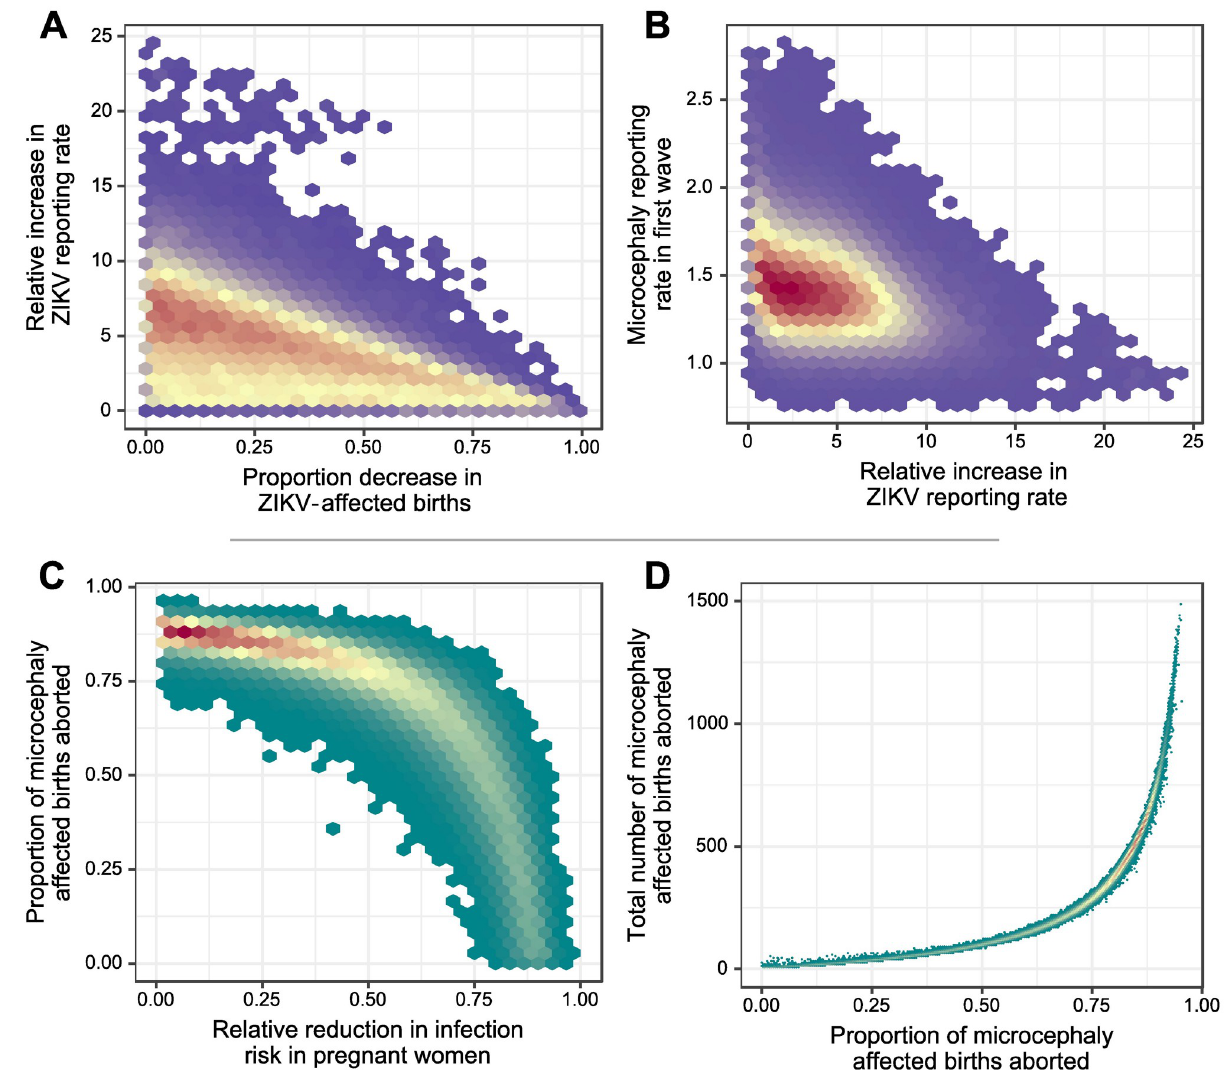
Fig 5. Key regions of parameter space that are consistent with the observed data. Unshaded regions show areas of parameter space that are less consistent with the observed data. Two-dimensional posterior density estimates for the behavioural and reporting changes necessary to explain the lack of a second microcephaly incidence wave in Bahia, Brazil. Parameter estimates are provided in S5 Table. Better supported regions of parameter space are indicated in red/orange, whereas less well supported regions are purple/turquoise. Plots A and B were estimated assuming that ZIKV reporting behaviour could have changed between the two waves, whereas plots C and D were estimated assuming that ZIKV reporting behaviour stayed the same throughout the epidemic. All estimates presented assumed that microcephaly reporting, targeted abortions and infection avoidance behaviour may have been present in the second wave, as described in the main text. A: Negative correlation between the increase in ZIKV reporting and increase in abortion rate, suggesting that the observed data could be explained by either mechanism in the absence of the other. B: Lack of correlation between ZIKV reporting and microcephaly reporting change estimates suggest that both mechanisms may independently explain observations. C: High correlation between the proportion reduction in ZIKV-affected pregnant women and the proportion of targeted abortions assuming no change in ZIKV reporting between the two waves, suggesting that high levels of either, or moderate levels of both mechanism are required to explain the data. D: Relationship between total aborted births between 02/03/2016 and 31/12/2016 and the proportion of ZIKV-associated microcephaly-affected births aborted, highlighting the actual number of aborted pregnancies that would have occurred given a particular abortion